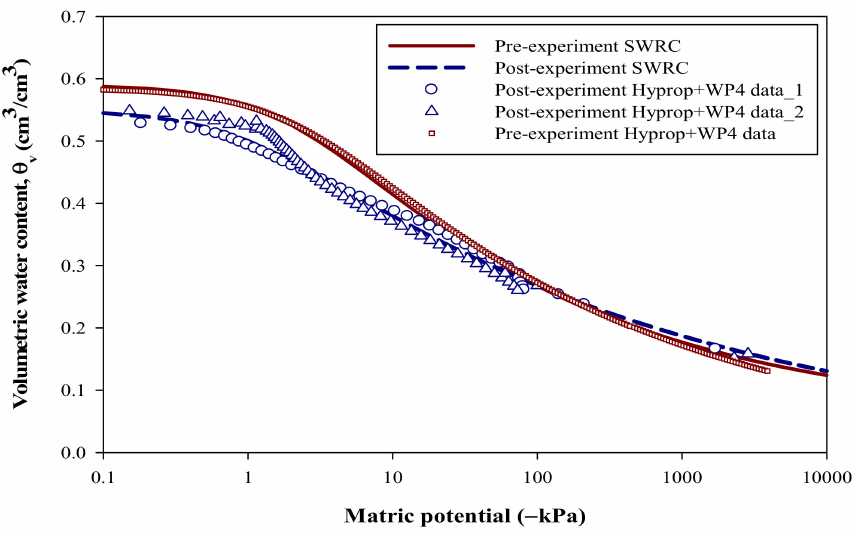
Figure 13. Comparison between pre-experiment and post-experiment soil water release curves